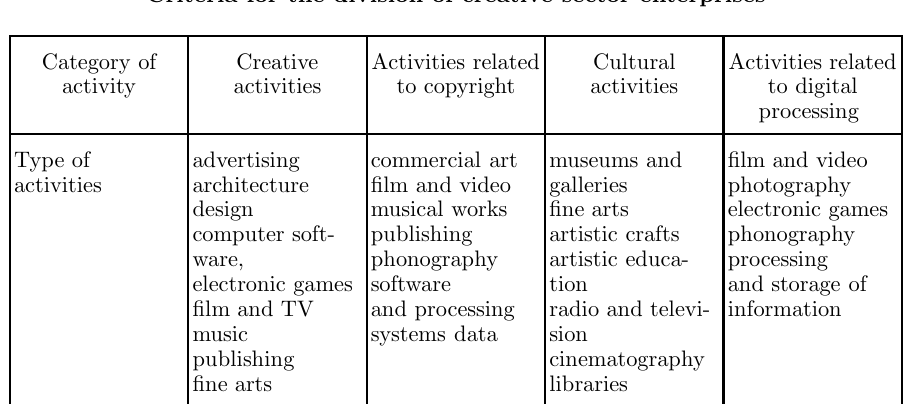
Criteria for the division of creative sector